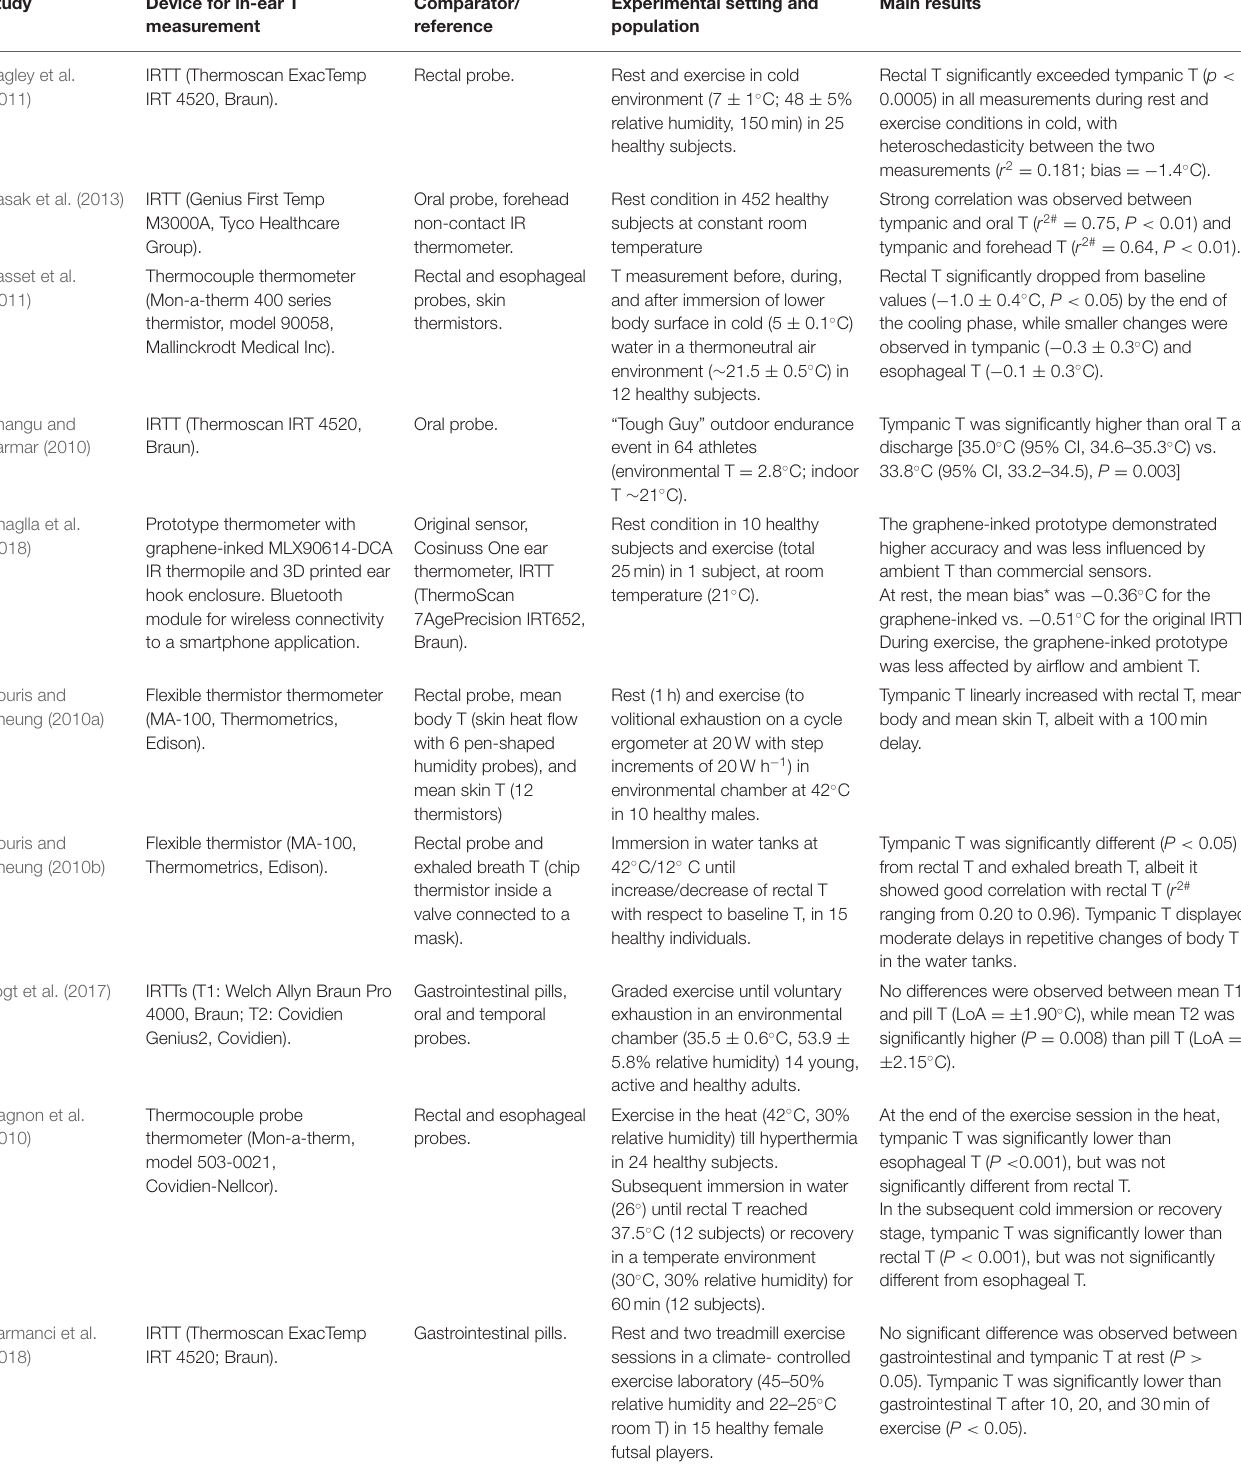
TABLE 2 | Included studies performing in-ear monitoring of